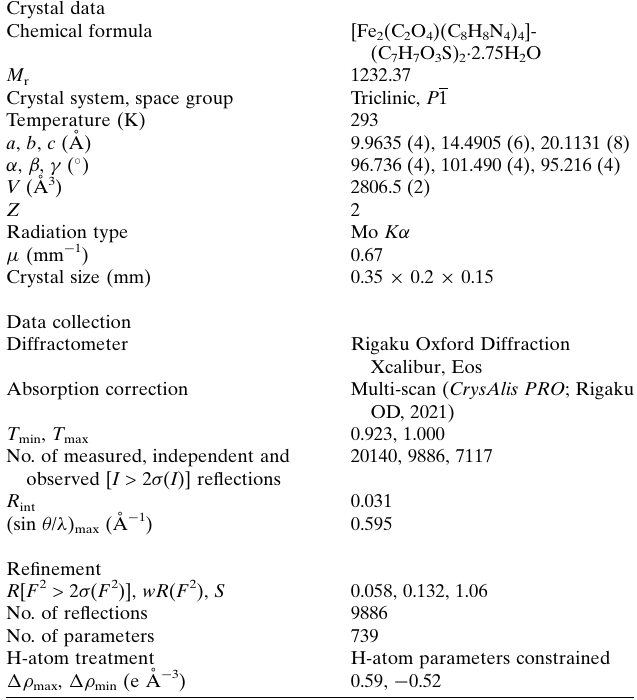
Table 3 Experimental details. Crystal data Chemical